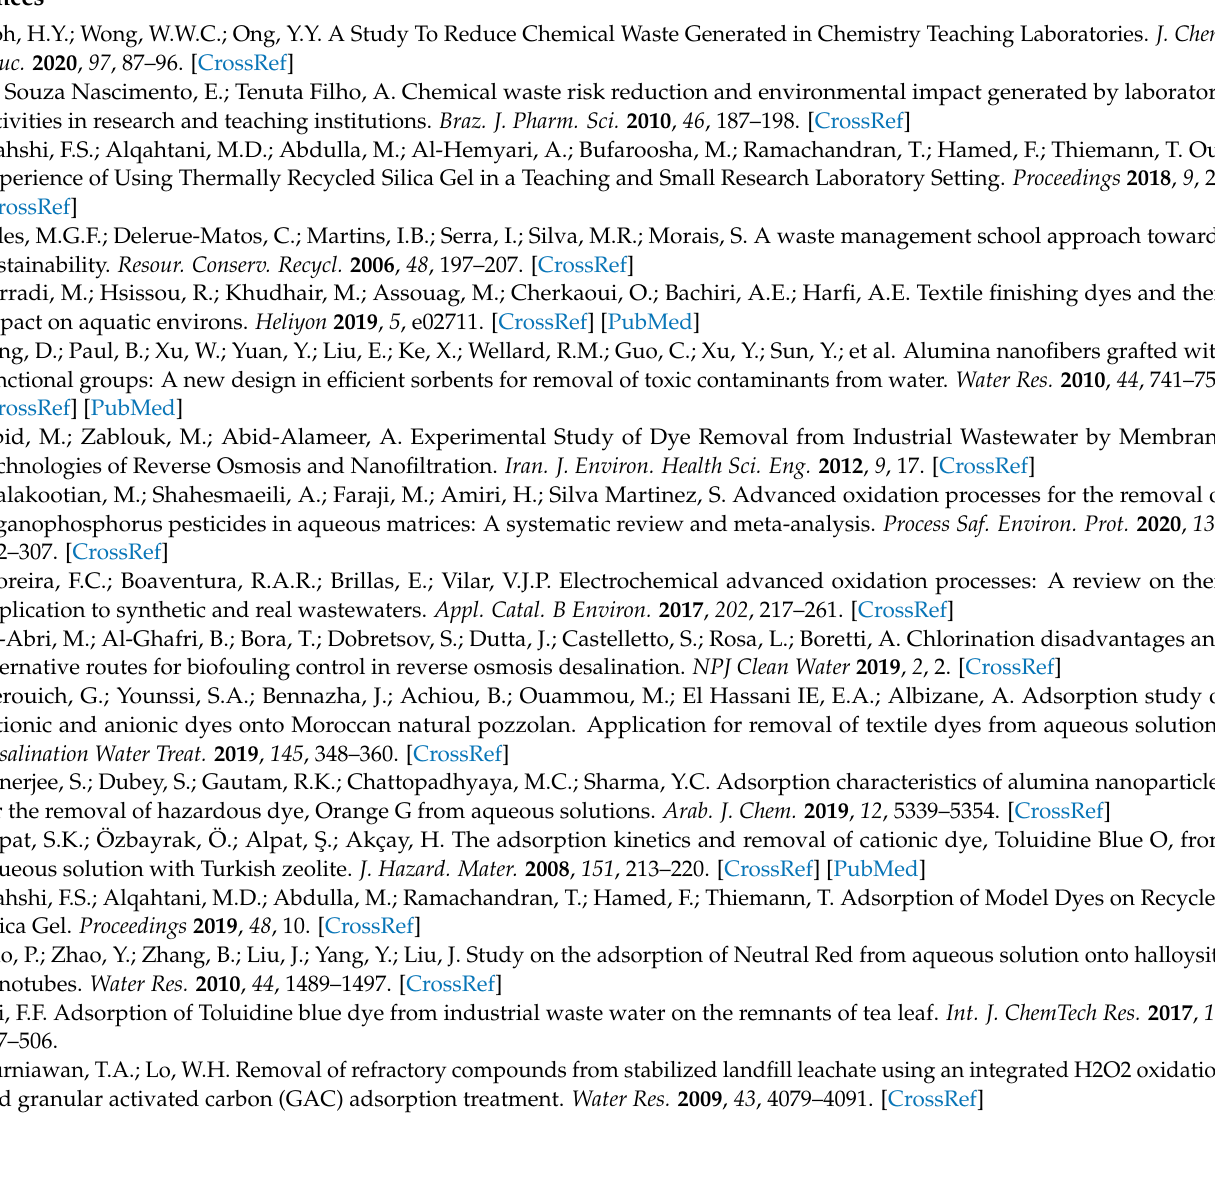
Figure S2: The N2 adsorption–desorption isotherm linear plot and surface area vs. pore width plot for (1A) the pristine acidic alumina sample before adsorption, (1B) acidic alumina after five-time regeneration, (2A) acidic alumina before adsorption, (2B) basic alumina after regeneration, (3A) used silica gel before adsorption, and (3B) used silica gel after